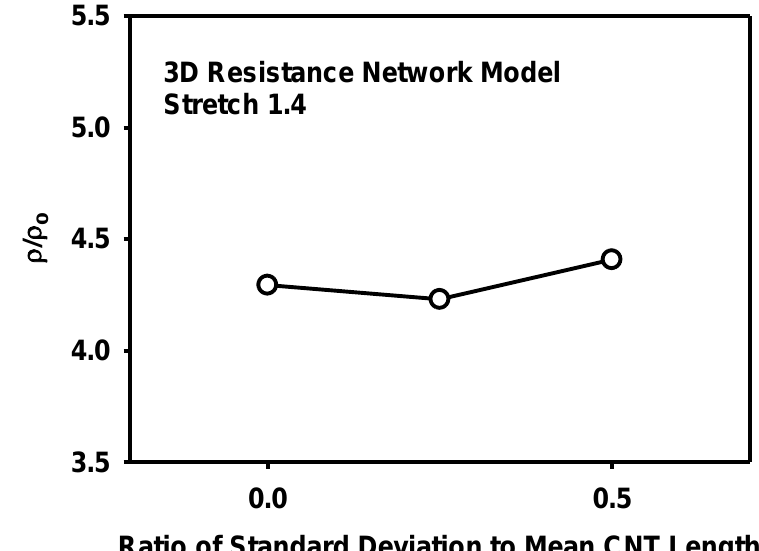
Figure 21. Effect of the CNT length distribution on the resistivity as calculated by the 3D resistance network model.